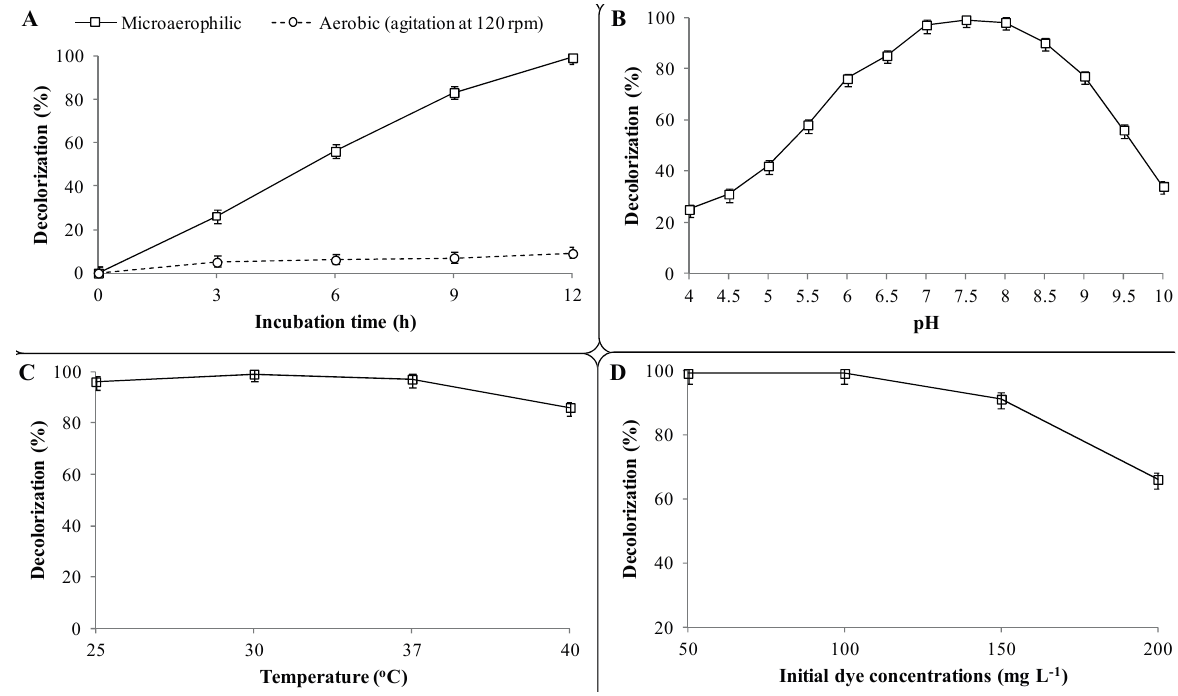
Figure 3. Batch studies on the effect of operational variables on the decolorization of CR dye by a PUF-immobilized microbial consortium. ( A ) Microaerophilic and aerobic incubation; ( B ) pre-grown culture medium Ph; ( C ) incubation temperatures and ( D ) initial CR dye concentrations. The percent decolorization was measured after 12 h of incubation at 30 ± 0.2 °C unless otherwise stated. Data points indicate the mean of three independent replicates; ±Standard errors of mean (SEM) is indicated by error